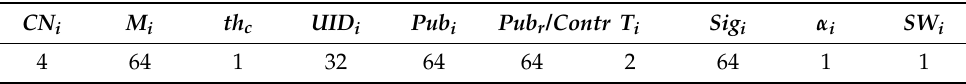
Table 1. Revocation message sizes